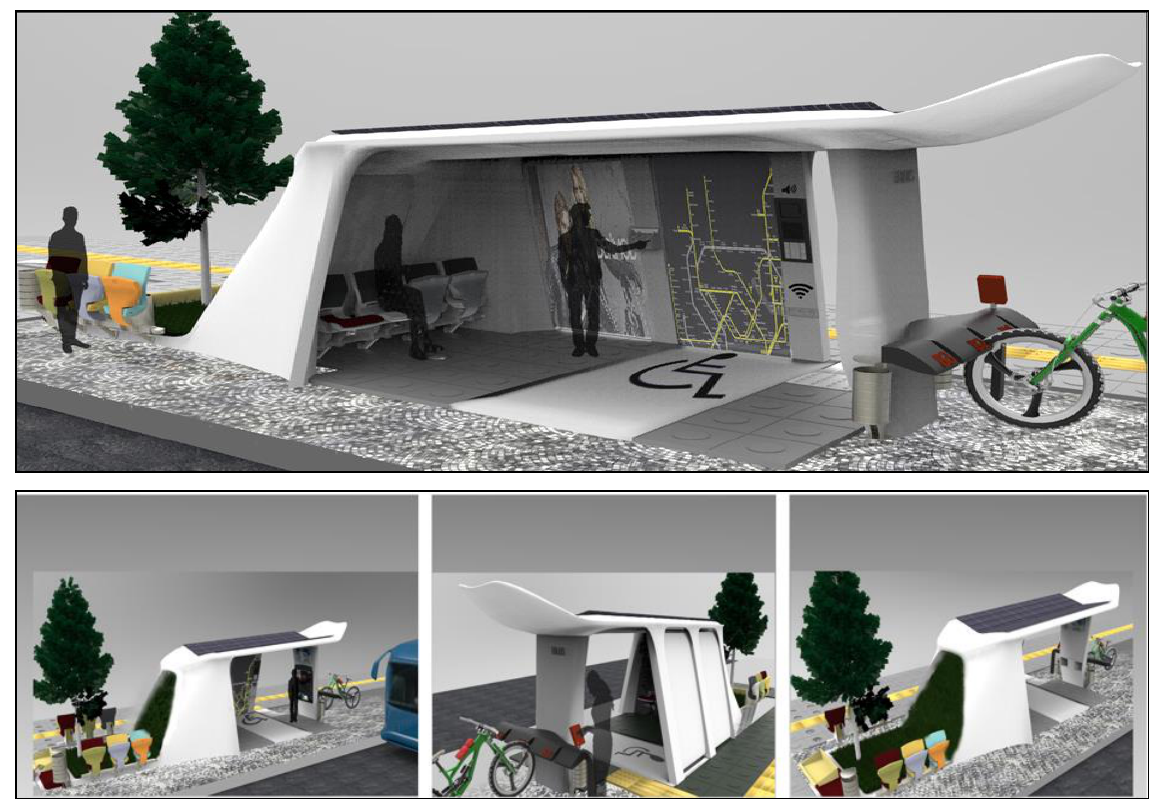
Figure 8. Design of Sustainable Smart Bus Station (Original,